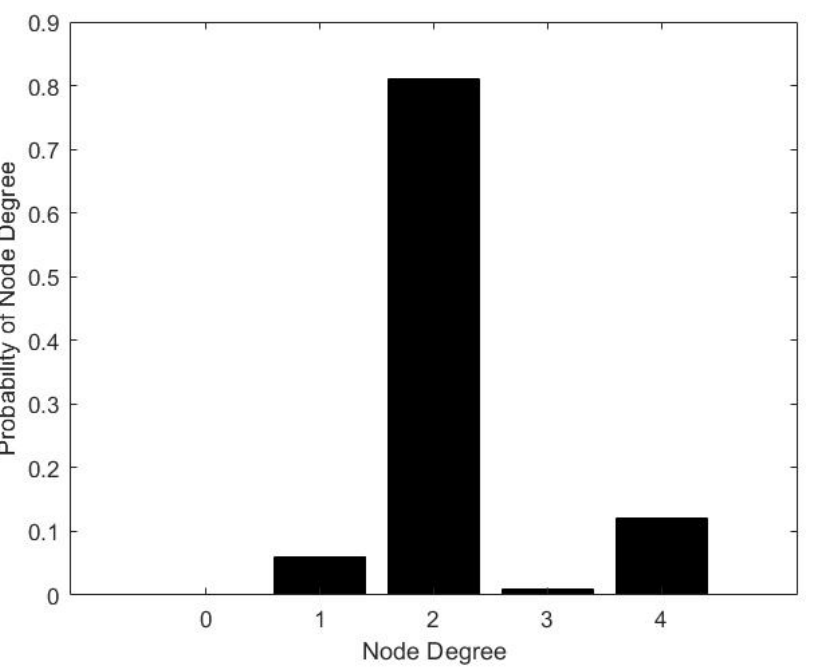
Figure 6. Probability of node degree of Zhengzhou metro network.